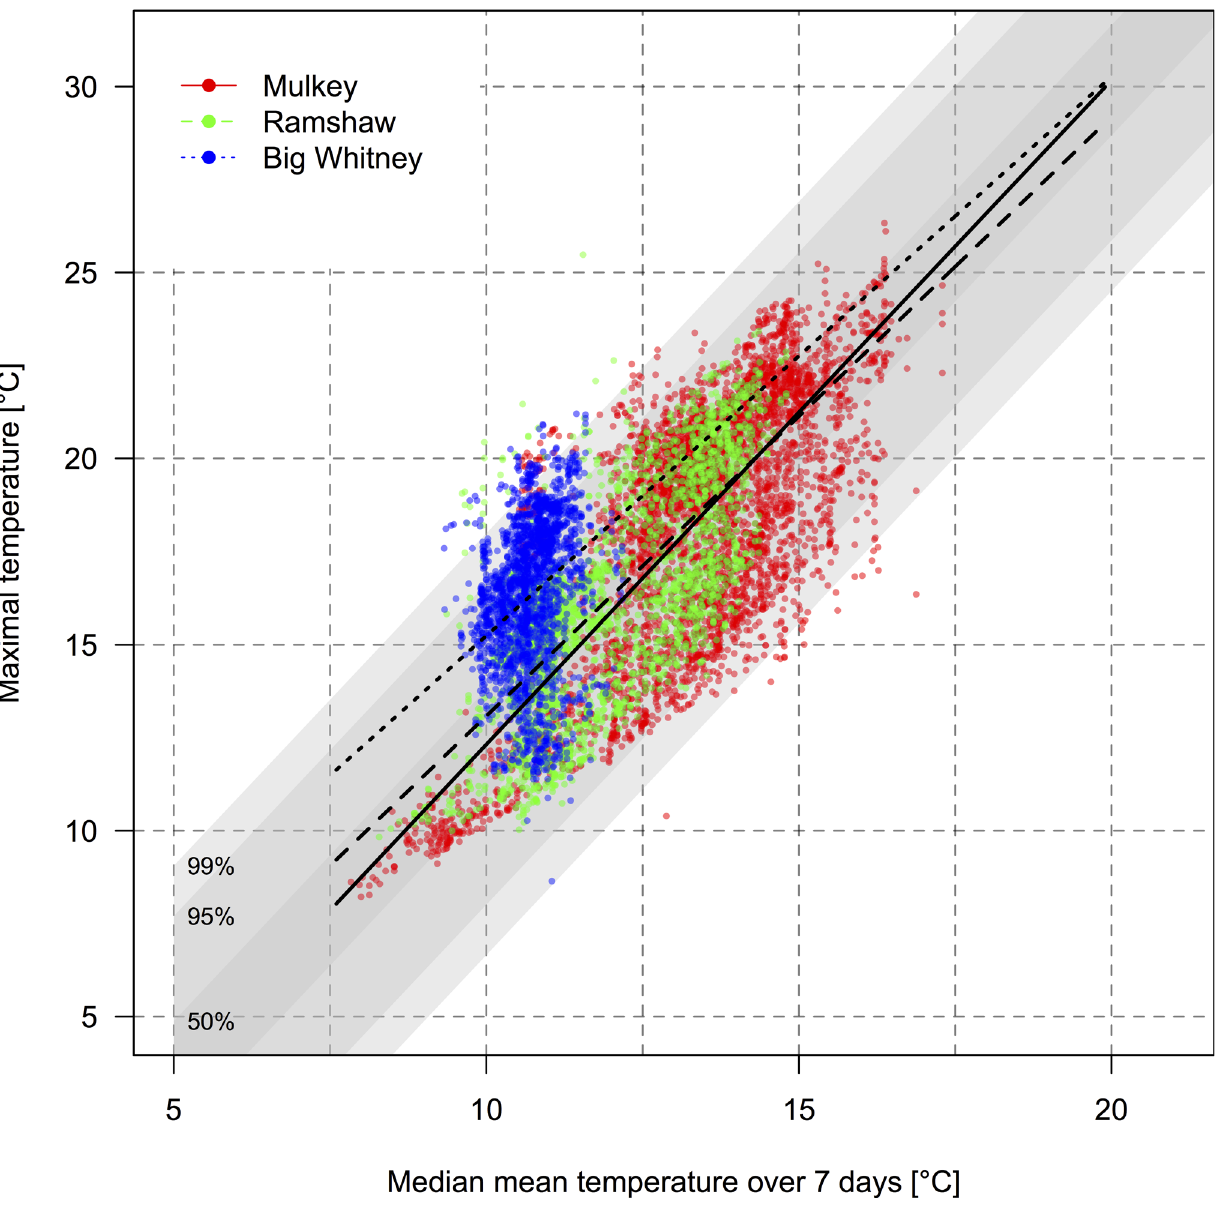
Fig 6. Temperature prediction model. Relationship between weekly average temperature (WavgT) [in °C] and the daily maximal temperature (DmaxT) [in °C], observed in one probe. Each point represents the temperatures from a single day measured at a single probe, red dots are for Mulkey Meadows, green dots for Ramshaw Meadows, and blue dots for Big Whitney Meadow. The three regression lines represent the three different meadows: Mulkey (solid), Ramshaw (dashed), and Big Whitney